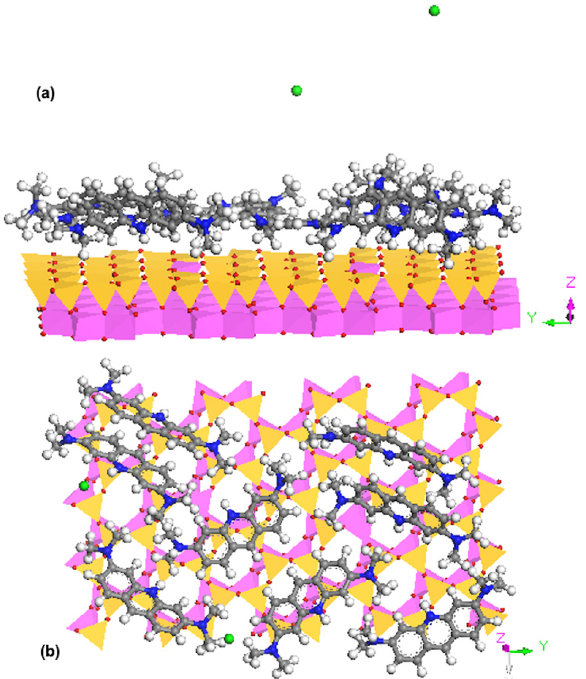
Figure 8. Molecular dynamics simulation showing sorbed AO forming a condensed monolayer on KAO at the amount equivalent to its CEC value of 0.03 mmol/g ( a , b ). Zn 2+ : Green.